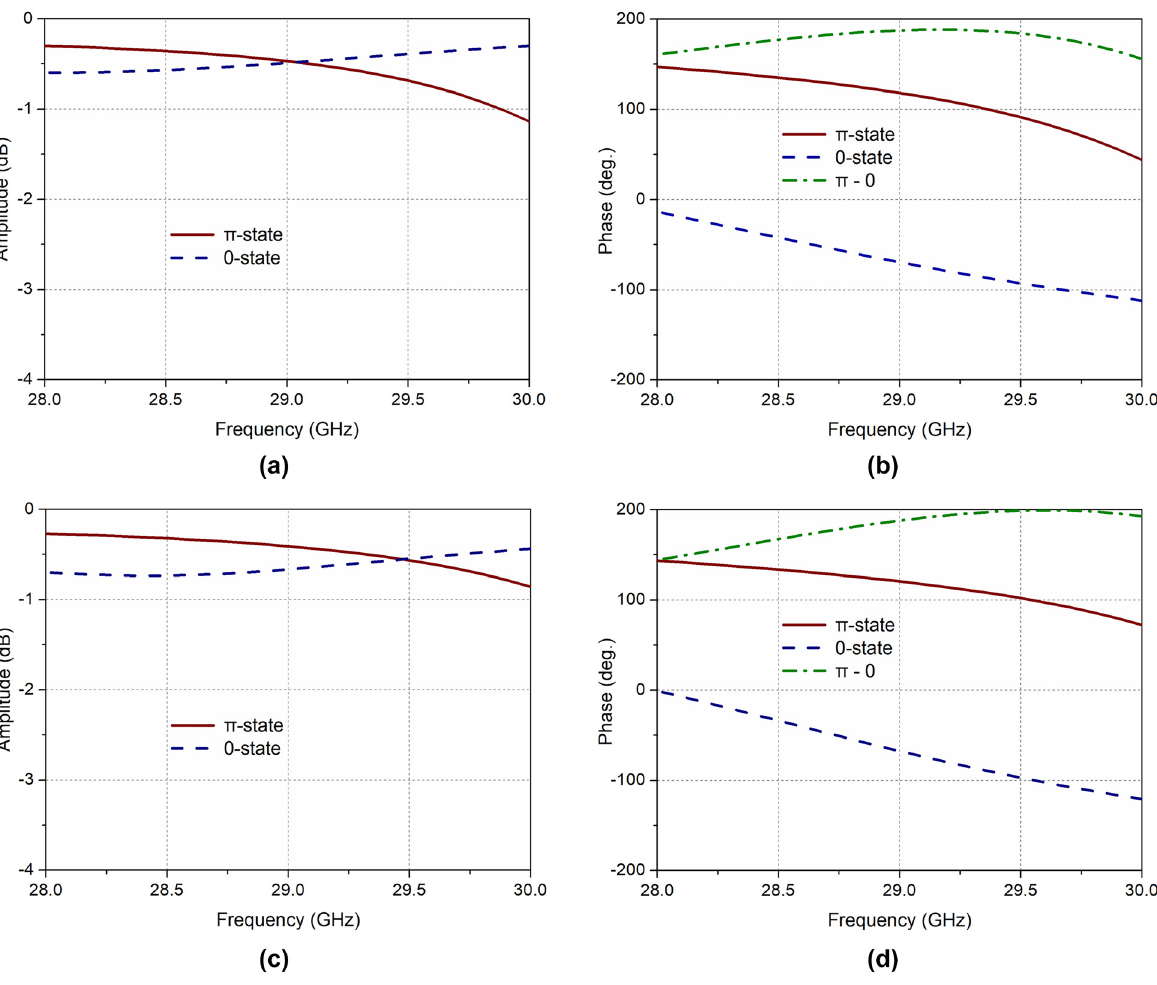
Figure 3: Simulated reflection coefficients of the unit. (a) Amplitude and (b) phase for both π /0 states with normal incidence. (c) Amplitude and (d) phase for both π /0 states with incidence angle θ = 30 °